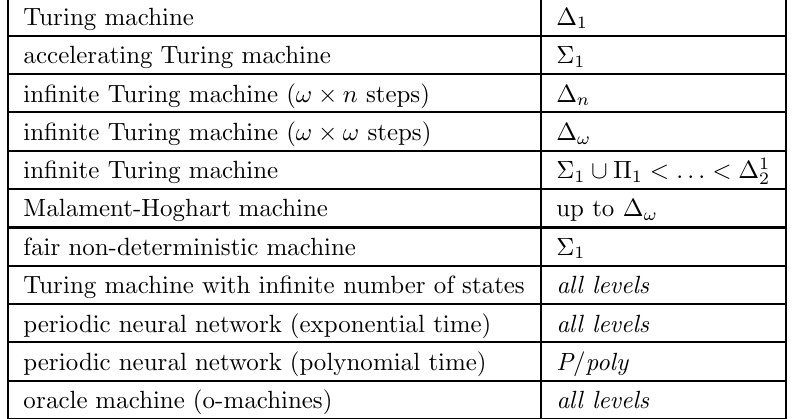
Computability according to the place within (or outside) the arithmetical hierarchy Turing machine ∆